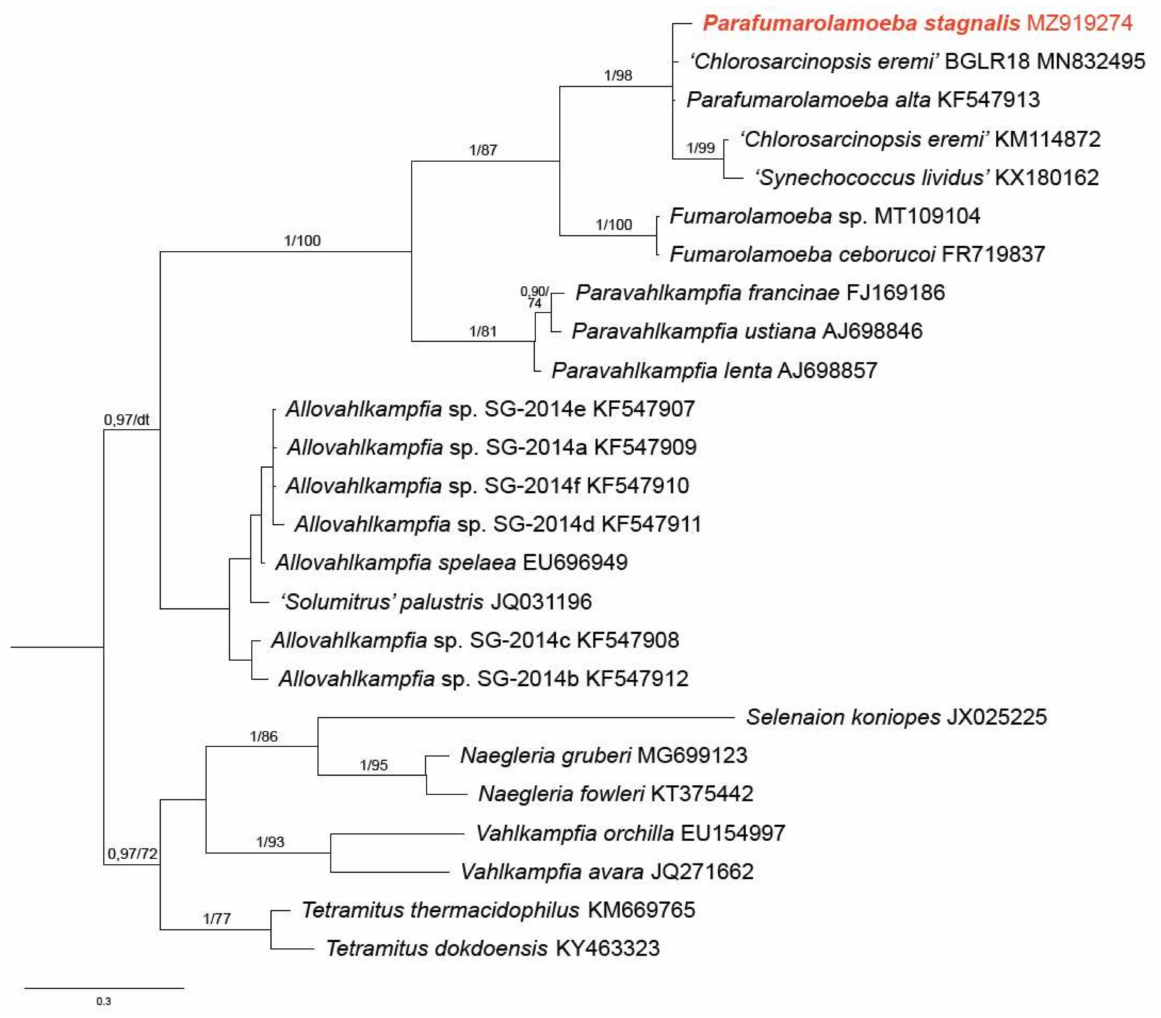
Figure 5. Bayesian phylogeny of the internal transcribed spacer (ITS) region. Bayesian posterior probabilities and Maximum Likelihood (TN+F+G4 model) bootstrap values are indicated at branches (values >0.9/>70 are shown; dt—different